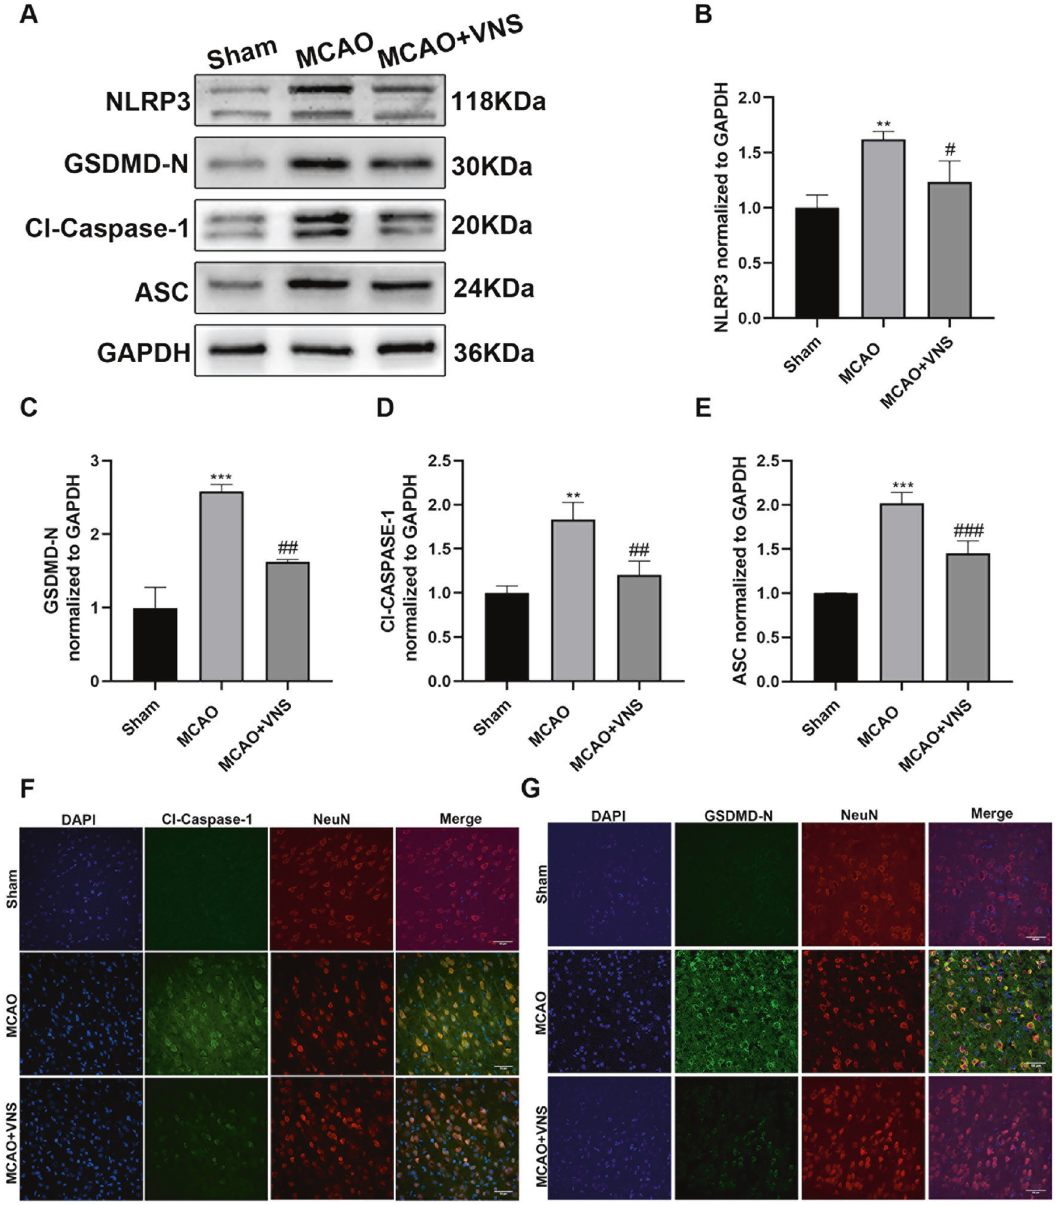
Fig. 2 VNS suppressed the expression of NLRP3 in fl ammasome after cerebral ischemia/reperfusion injury. A – E Immunoblotting analysis for NLRP3, GSDMD-N, cleaved caspase 1 (Cl-Caspase-1), and ASC ( n = 6 per group). VNS signi fi cantly downregulated the contents of NLRP3, GSDMD-N, Cl-Caspase-1, and ASC when compared to the middle cerebral artery occlusion (MCAO) group. ( F , G ) Representative immuno fl uorescence images of Cl-Caspase-1 and GSDMD-N co-stained with NeuN. VNS reduced the amounts of Cl-Caspase-1-positive and GSDMD-N-positive neurons when compared with the MCAO group. Scale bar = 50 μ m. ** P < 0.01, *** P < 0.001 versus the sham group and # P < 0.05, ## P < 0.01, ### P < 0.001 versus the MCAO